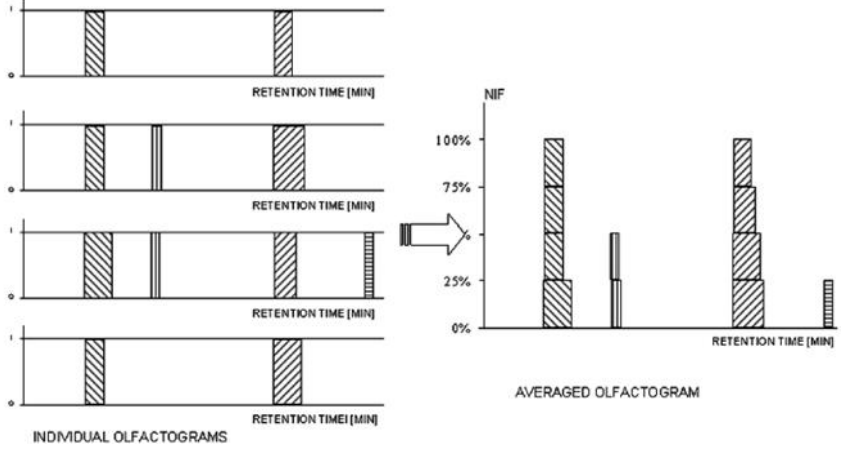
Figure 3. Scheme of an aromagram obtained using detection frequency methods, with four evaluators (reprinted from [22] with permission from